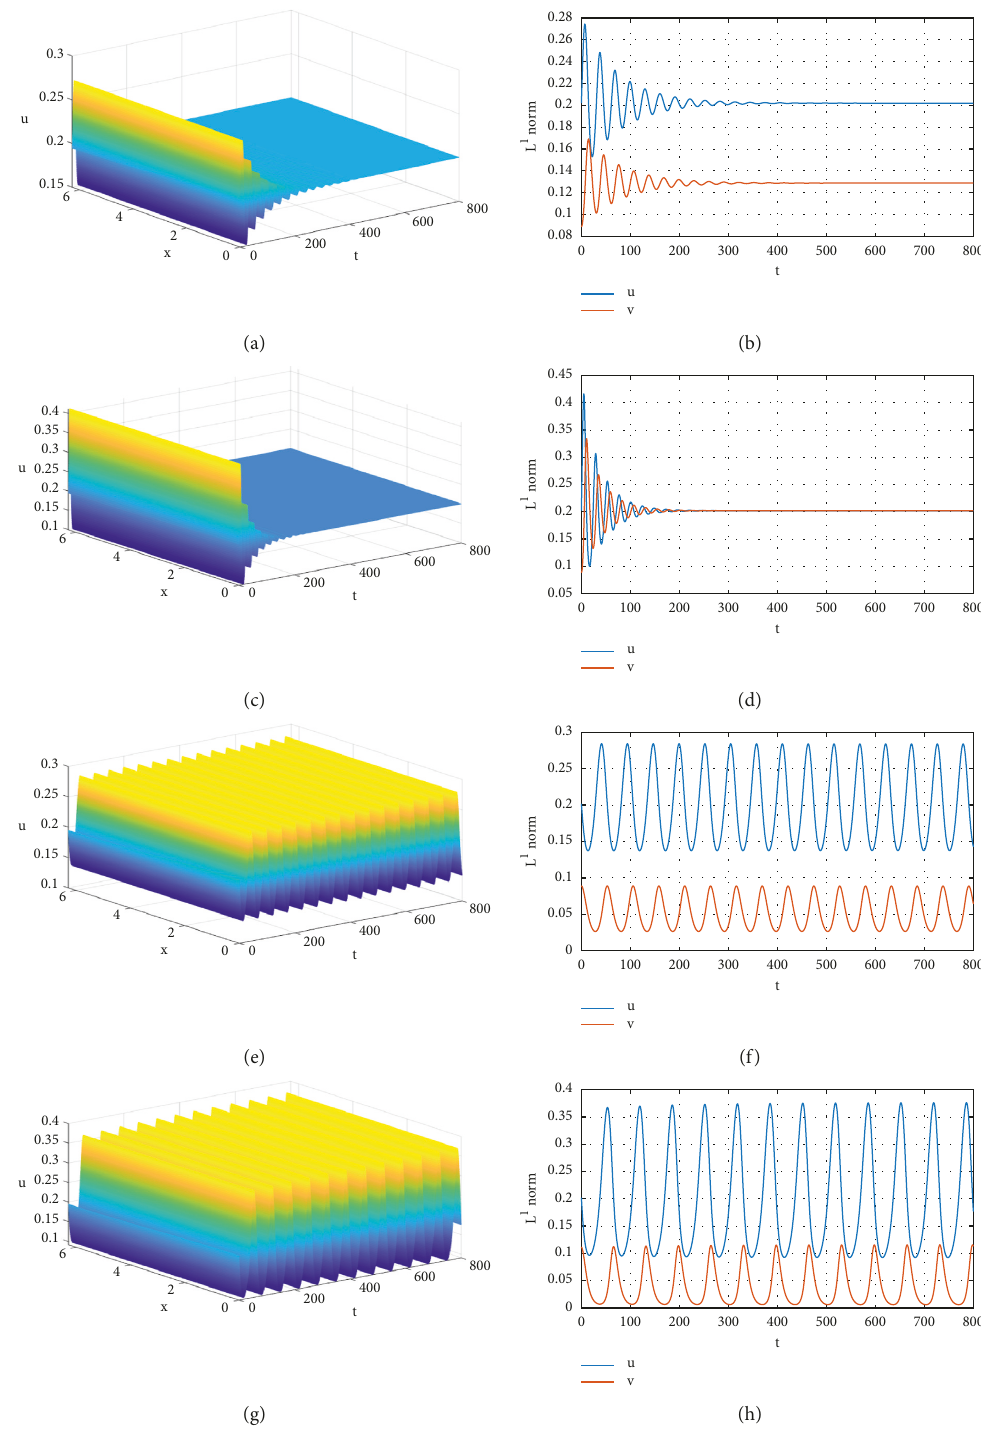
Figure 1: The effects of parameter m for T � 800 ,l � 2. The values of parameter m are as follows: (a, b) m � 0 . 3; (c, d) m � 0; (e, f) m � 0 . 495; (g, h) m � 0 . 51. The right column is the L 1 norm of u and v